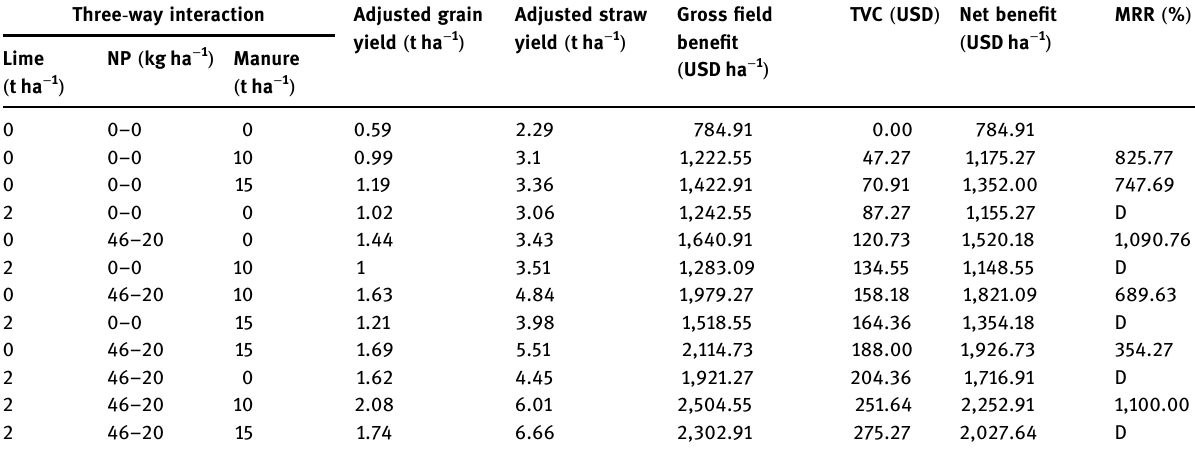
Table 6: Partial budget analysis of combined over years grain and straw yields of tef as in fl uenced by soil amendments in 2016 and 2017 main cropping season in northwest Ethiopian highlands Three - way